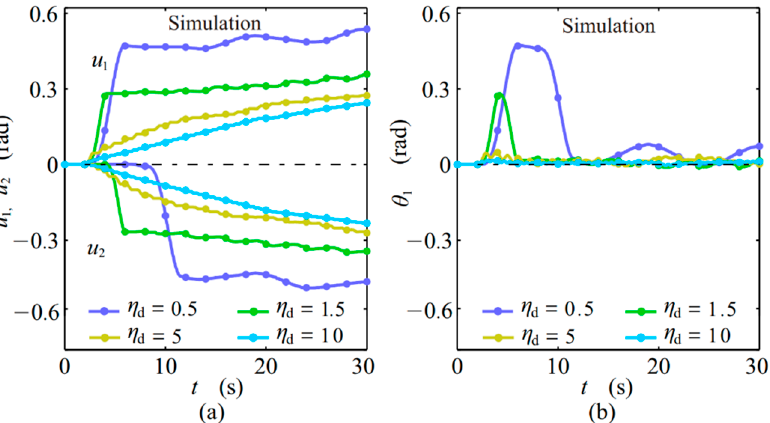
Figure 10. Serial-stiffness-switch system simulation results for harmonic disturbances under different η d , here (cid:98) M d = 0.05Nm and η s = 100. ( a ) Deformations of the two springs, u 1 and u 2 ; ( b ) displacement of the primary plate, θ 1 .